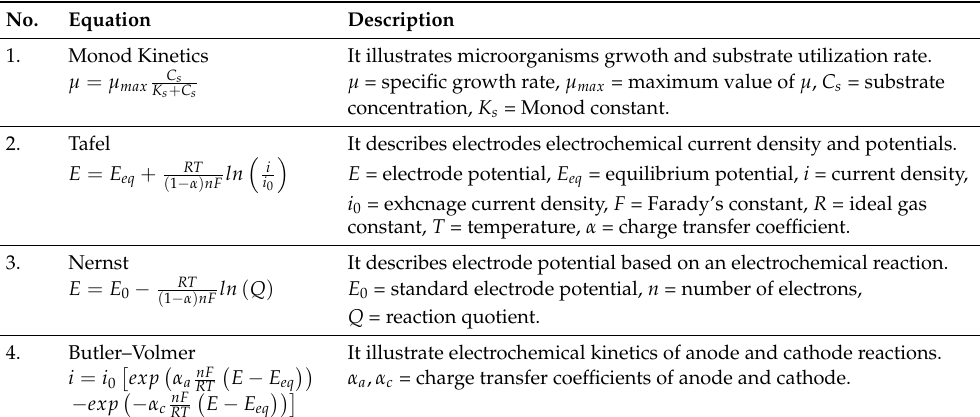
Table 2. Equations in physical and bio-electrochemical models of Microbial Fuel Cells